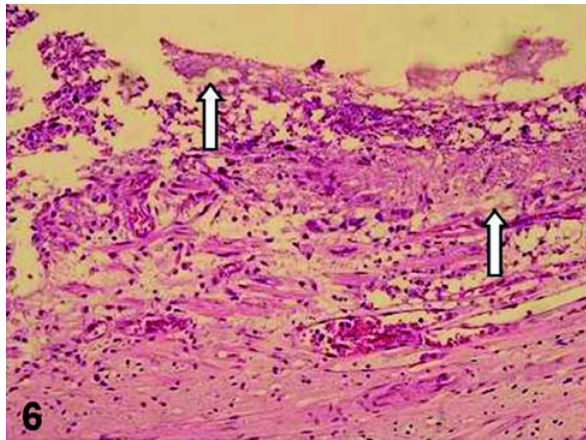
FIGURE 7- Deep cavity was prepared in human premolar. In this figure it is shown the pulp tissue related to the cavity floor in which total etch was applied and an adhesive system and composite resin were used for cavity restoration. Sixty days after the clinical procedure the tooth was extracted and processed for histological evaluation. Note the intense inflammatory response as well as the zone of inner dentinal resorption (arrow). HE,